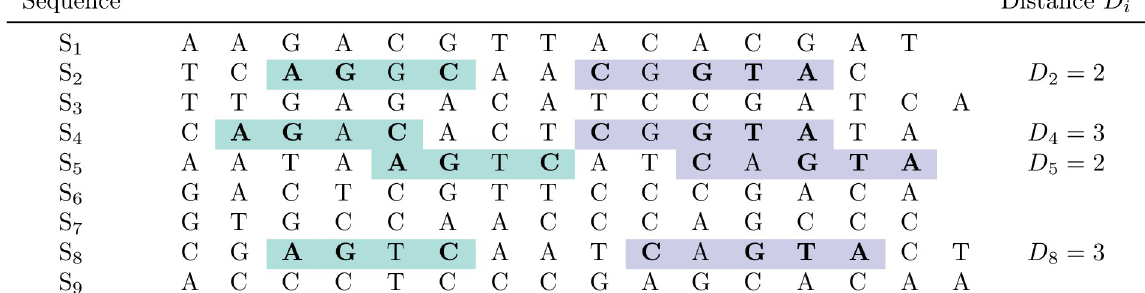
while the alternative two quartet topologies i